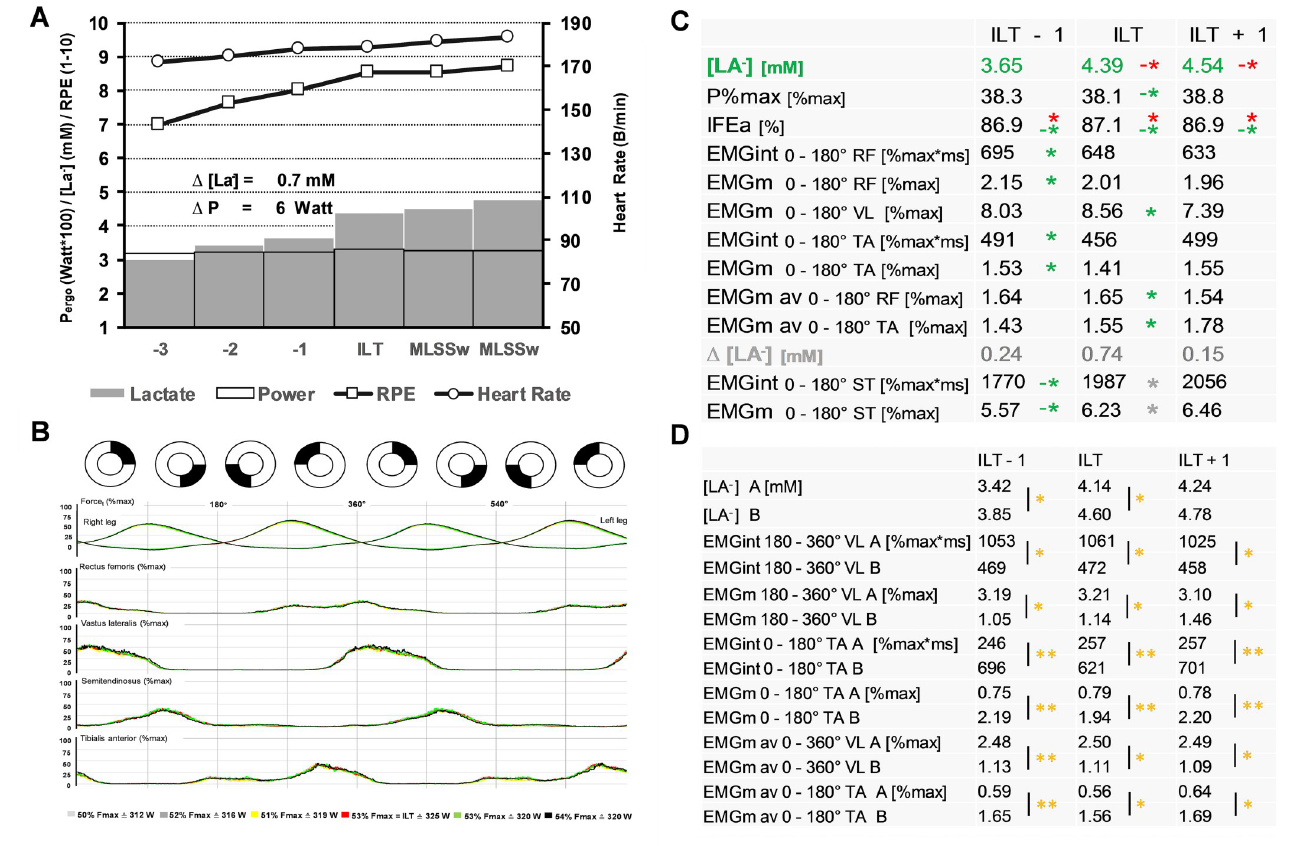
Fig 10. Force, EMG and lactate kinetics around the lactate threshold in ILT-tests. (A) Summary of ILT-tests (n = 11). Blood lactate concentration (mM), Pergo (Watt), rate of perceived exertion (RPE, 1-10) and heart rate (beats/min) for the final 6 increments of ILT-tests. A step-like blood lactate accumulation occurs at the individual lactate threshold (ILT, Δ [La − ] = 0.7 mM) after a slight workload increment ( Δ P = 6 Watt). Immediately after a comparable slight workload reduction ( Δ P = 5 Watt), lactate accumulation slows down, indicating the maximal lactate steady state workload (MLSSw) [24]. (B) Averaged bi- pedal crank force and EMG data across two pedal cycles (0–720˚) (n = 11) during three increments before and during two increments after the ILT. There are no visible differences in force and recruitment patterns. (C, D) Relationship of capillary lactate concentration [La − ] to MLSSw/kg, mechanical and EMG parameters (C) and differences in lower limb muscle activity between group A and B (D) for the pre-ILT stage, at the ILT and for the post-ILT stage, calculated for each revolution. P%max is shown as mean of both cranks. IFEa is shown as mean of the right crank. For detailed description of data analysis and parameter definitions see Methods and S1 Fig. Red asterisk ( � ): correlation to MLSSw/kg (C) , green asterisks ( � ): correlation to [La − ] at ILT (C) , grey asterisks ( � ): correlation to Δ [La − ] (C) , yellow asterisks ( � ): two-tailed unpaired t-tests (D) . Shown is mean. � P < 0.05, �� P < 0.01.